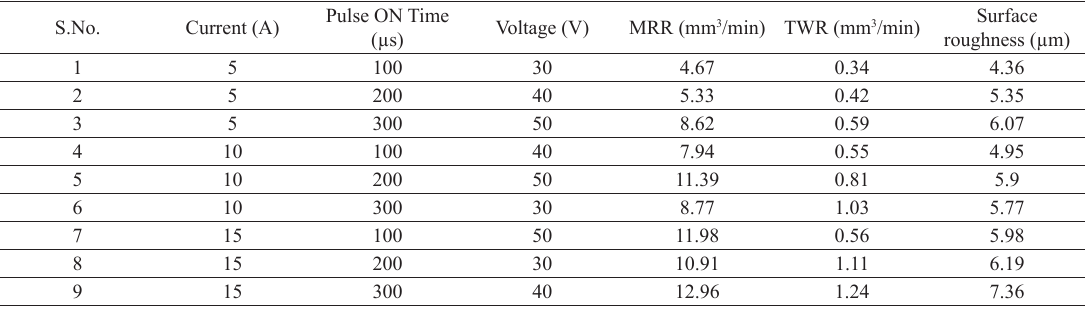
Table 1. EDM experimental results.